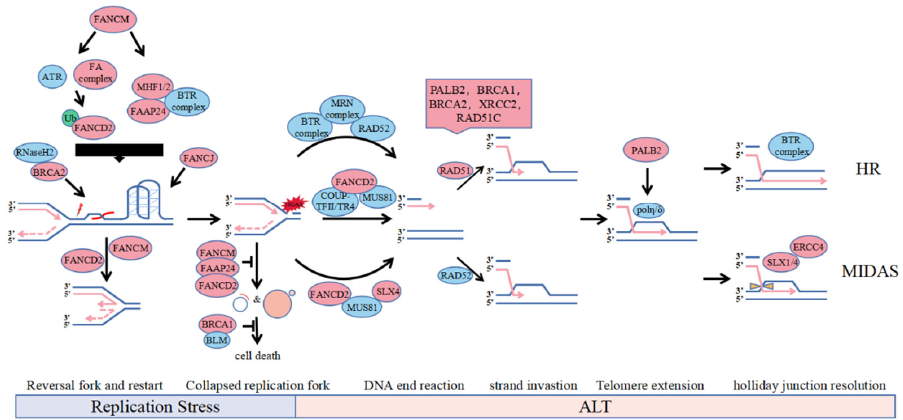
Figure 1. Involvement of FA protein in the ALT pathways. The accumulation of telomere secondary structure such as R-loops and G-quadruplexes may lead to replication fork stalling. During replication stress, the slow or stalled replication fork can undergo fork reversal and restart by FANCD2 and FANCM. BRCA2 can recruit RNaseH2 to unwind R-loop and FANCJ can solely resolve G4 on ALT telomeres. Depletion of FANCM or FANCD2, which is synthetically lethal with BRCA1 or BLM, reduces the replication efficiency of telomeric DNA and increases formation of ECTR and micronuclei. However, unresolved replication stress leads to fork collapse and genome instability catalyzed by nucleases including SLX4 and MUS81 recruited by FANCD2, which provides direct DNA lesion or DSB for substrates to induce BIR mediated ALT. Recruitment on telomere of HR factor for strand invastion in S phase, polη stabilized by PALB2 for telomere extension and SLX1/4 for recombination intermediate dissolution in mitotic phase contribute to ALT-mediated recombination and telomere synthesis.